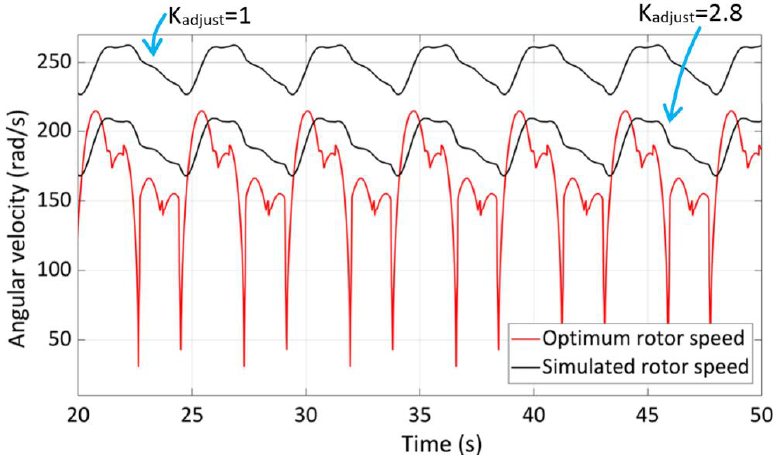
Figure 17. Optimum and simulated rotor speeds with H s = 1 m, T p = 4.3 s using the model of Figure 13. Table 4. Powers and efficiencies obtained considering an Impulse turbine, with MPPT control; K adjust = 1.